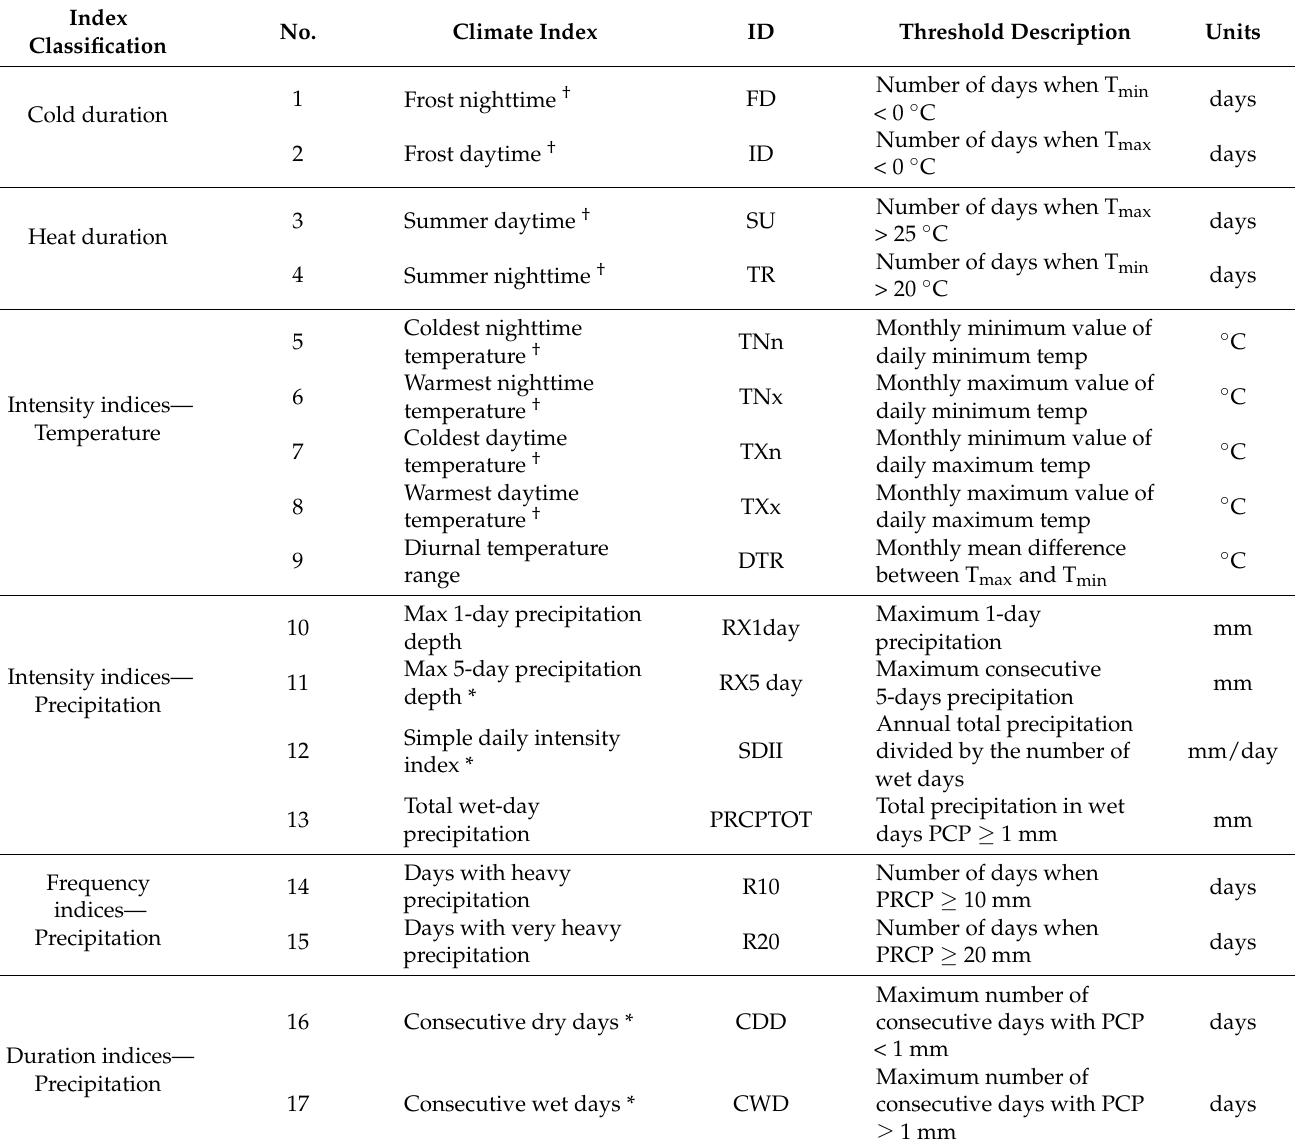
Table 2. Summary of all 17 ETCCDI climate indices analyzed in this study, grouped according to its